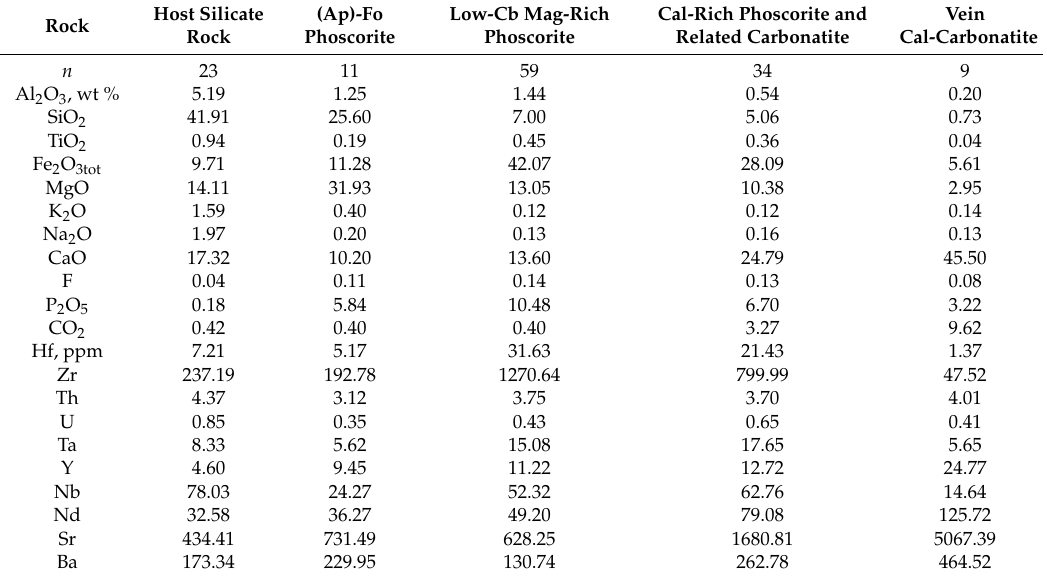
Vein Cal-Carbonatite